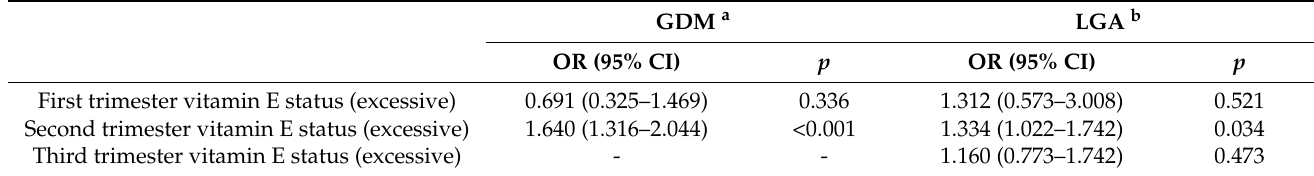
Table 5. The association between vitamin E status and GDM and large for gestational age (LGA), by multivariate logistic regressions.